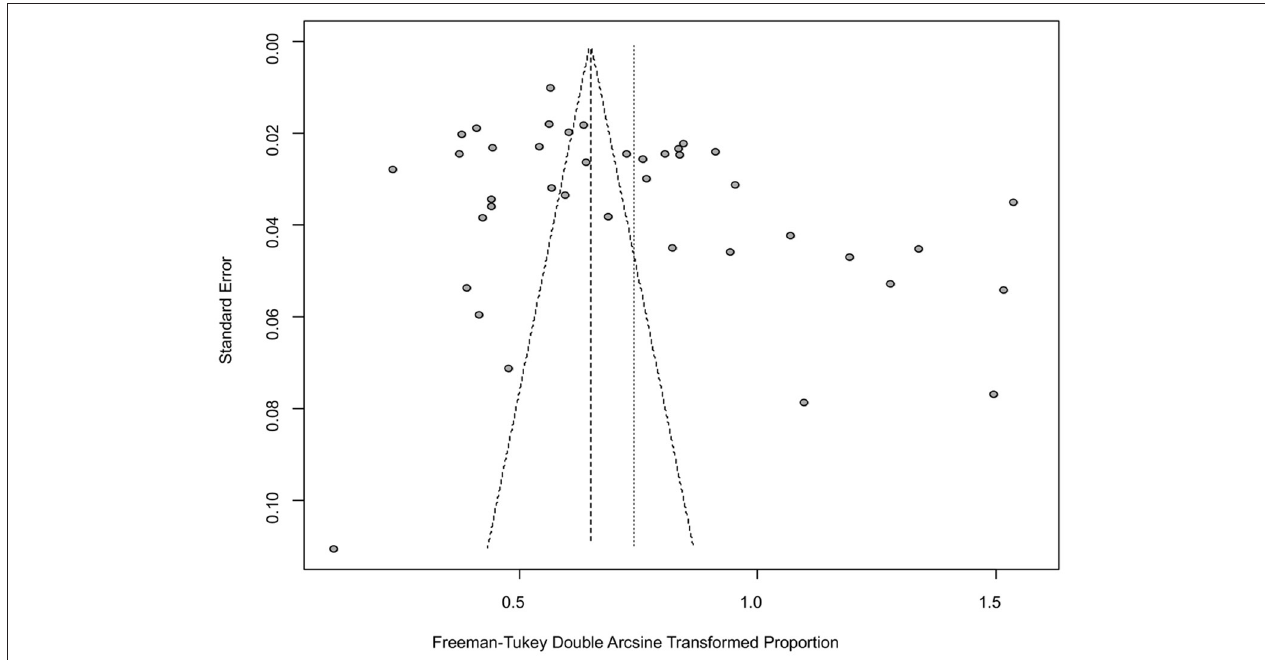
FIGURE 4 | Funnel plot with pseudo 95% confidence interval limits for the examination of publication bias.